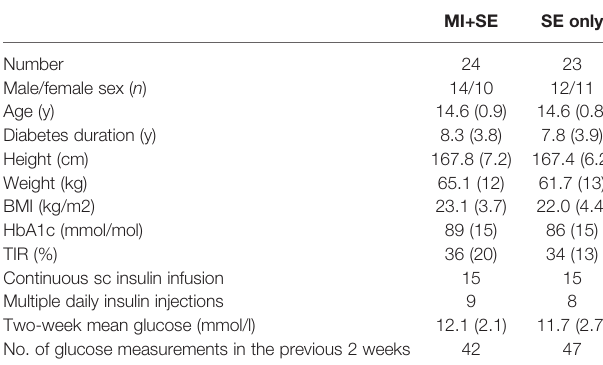
TABLE 1 | Characteristics of study subjects at baseline, presented as mean values (SD), except for the number of glucose measurements (median).